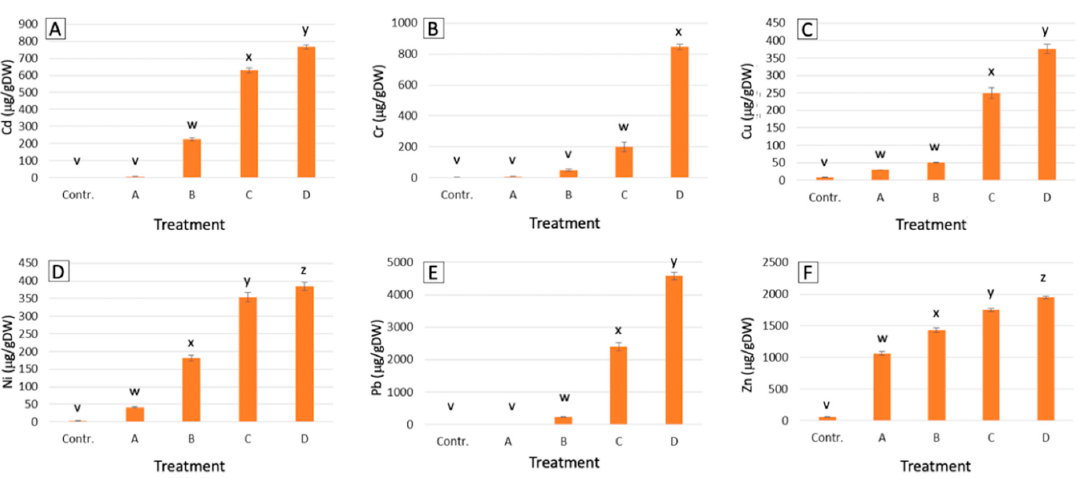
Figure 2. Metal contents in shoots of S. vulgaris grown in hydroponics at increasing metal concentrations (from control to D, see Methods section). ( A ) Cd; ( B ) Cr; ( C ) Cu; ( D ) Ni; ( E ) Pb; ( F ) Zn. Bars represent the average of data coming from five populations analyzed in three biological replicates ( n = 15). Different small letters (from v to z) above the bars indicate a statistically significant difference among the treatments ( p < 0.05 ) calculated with Dunn.test using R software.